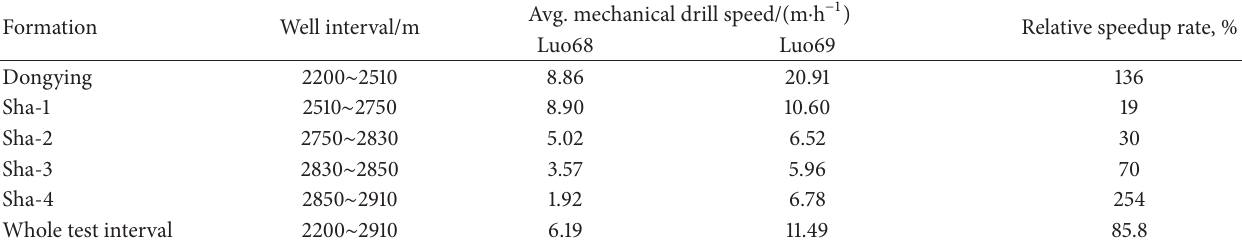
Table 1: Comparison of average mechanical drilling speeds of Luo69 and Luo68 within same well intervals. Formation